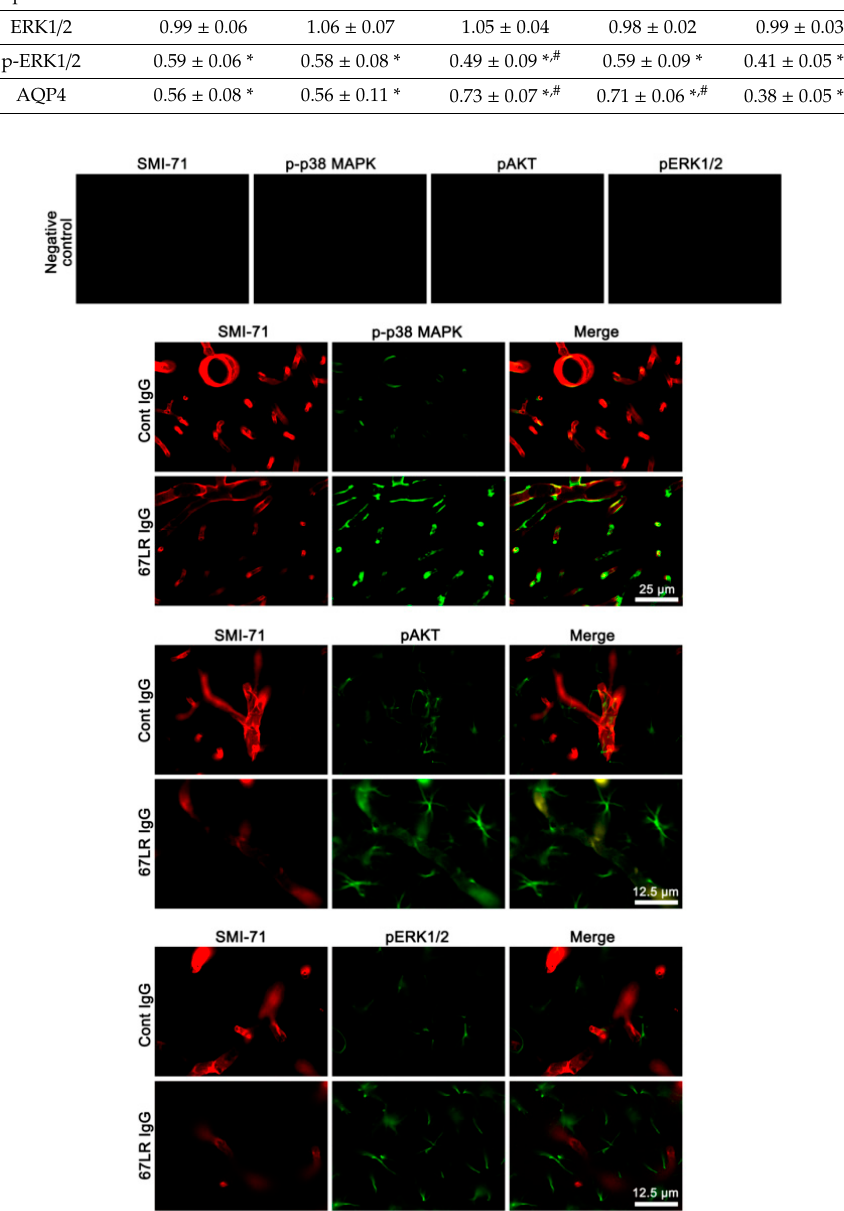
Figure 3. Localizations of SMI-71, p-p38 MAPK, pAKT, and pERK1/2 expression in the PC following 67LR neutralization. Up-regulations of p-p38 MAPK and pAKT expression are observed in endothelial cells following 67LR IgG infusion, accompanied by reduced SMI-71 expression. However, the pERK1/2 signal is rarely detected in endothelial cells.